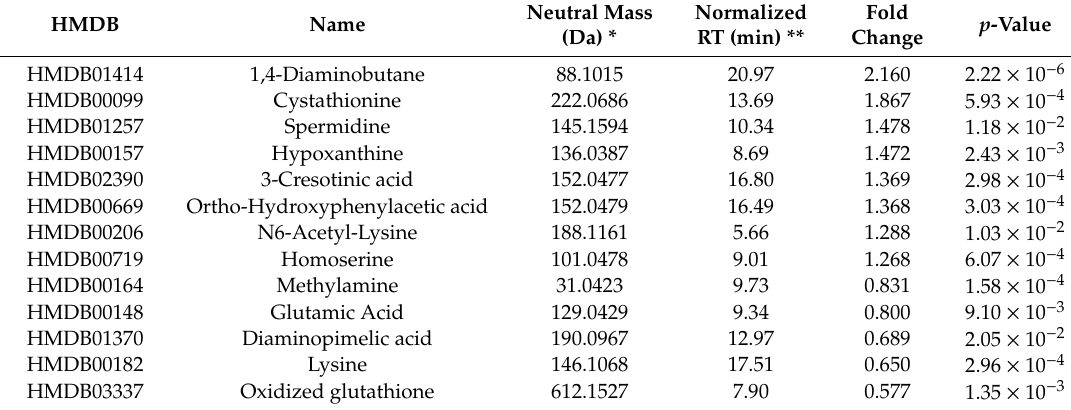
Table 6. Positively identified significantly differentially expressed metabolites in the rat skeletal muscle tissue after prolonged Dex treatment.